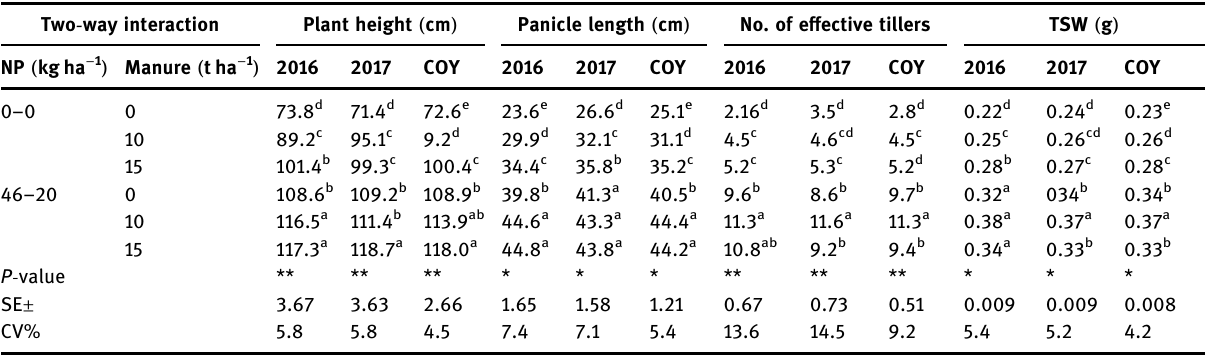
Table 4: Interaction e ff ects of cattle manure and NP fertilizers on vegetative growth and yield parameters of tef in 2016 and 2017 main cropping season in northwest Ethiopian highlands Two - way